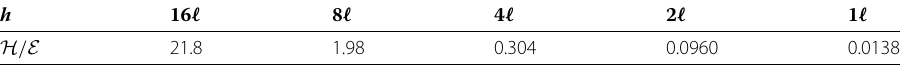
Table 2 Hourglass energy H relative to the total elastic energy E of the specimen for Q4G1 element as a function of the element size h ∈ { 1 , 2 , 4 , 8 , 16 } (cid:4)